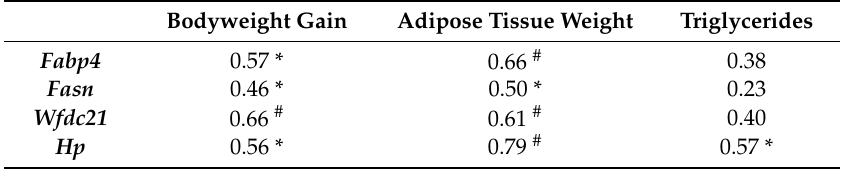
Table 4. Correlation between the adipocyte mRNA expression and physiological parameters in 2.5% GSF with heat-treated LAB (GSF+HLAB), and heat-treated LAB (HLAB) for 8 weeks. Bodyweight Gain Adipose Tissue